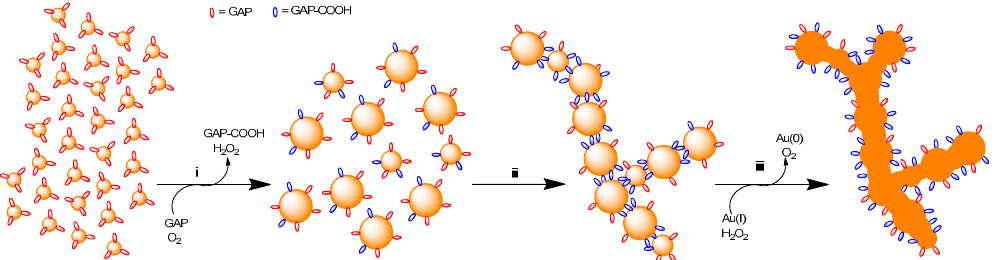
Figure 9. Cartoon rendition of AuNPs evolution towards nanowires: ( i ) GAP (red) poorly-passivated, small AuNPs grow by clustering and coalescence; the nanoparticles catalyze the oxidation of GAP to GAP-COOH (blue) and O 2 is reduced to H 2 O 2 ; ( ii ) larger nanoparticles aggregate to form necklaces in a process mostly driven by GAP-COOH. Ramifications occurs because of the less selective aggregation of smaller nanoparticles; ( iii ) residual Au(I) is reduced to Au(0) by H 2 O 2 and this induces fusion and nanowires formation.